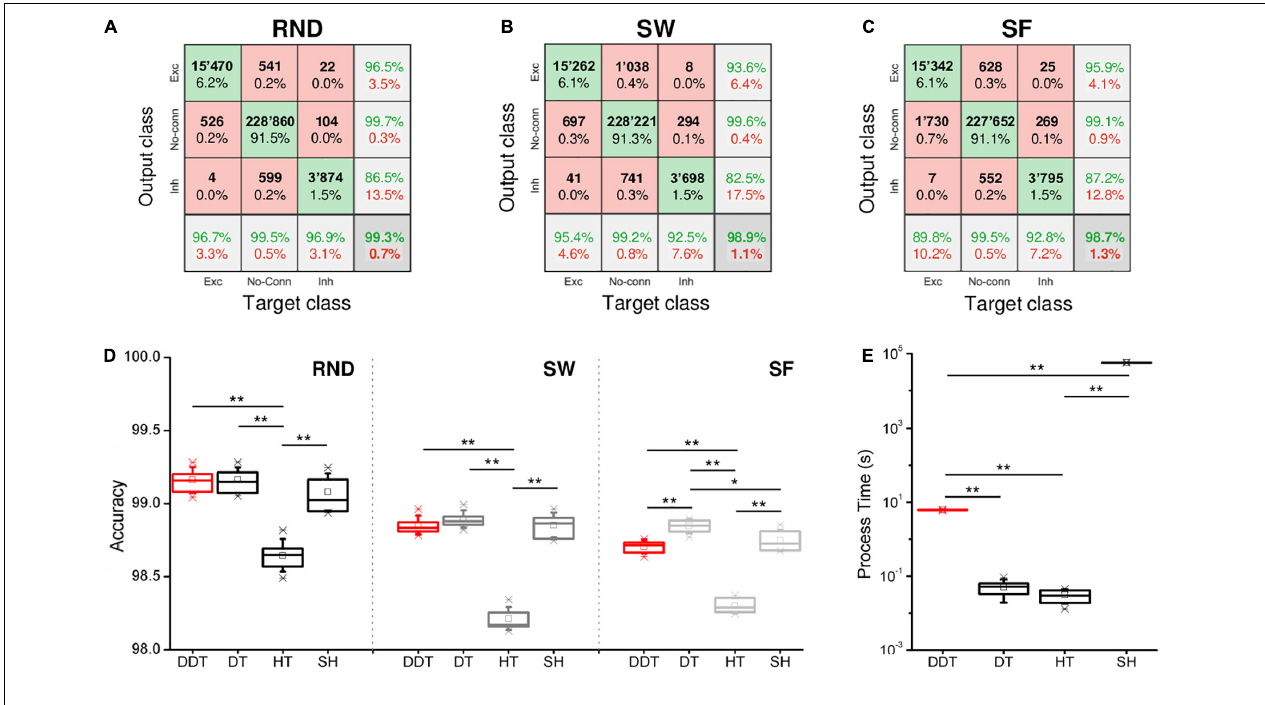
FIGURE 5 | Accuracy of the thresholding methods. Three examples of confusion matrices obtained with the DDT algorithm for (A) RND, (B) SW, and (C) SF topologies. The target and the output classes have been divided in excitatory (Exc), absent (No-Conn), and inhibitory (Inh) connections. Green/red squares indicate correct/incorrect number/percentage of classified links. (D) Accuracy evaluated through confusion matrices over all kind of topologies and thresholding algorithms. (E) Computational time requested by each method to threshold n = 6 CM of RND networks (* p < 0.05, ** p < 0.01, Kruskal–Wallis, non-parametric